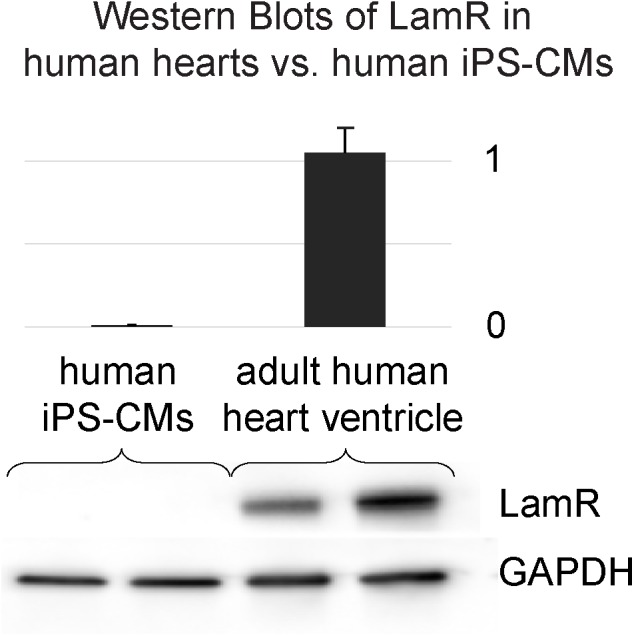
The 37/67 kDa LamR is expressed in the intact human heart. Western blots of LamR protein in fresh samples from male and female human hearts and from cultured hiPS-CMs corroborate the difference in expression (lack of LamR in the cultured myocytes and abundance in the intact human heart). GAPDH was used as a loading control and for normalization purposes.